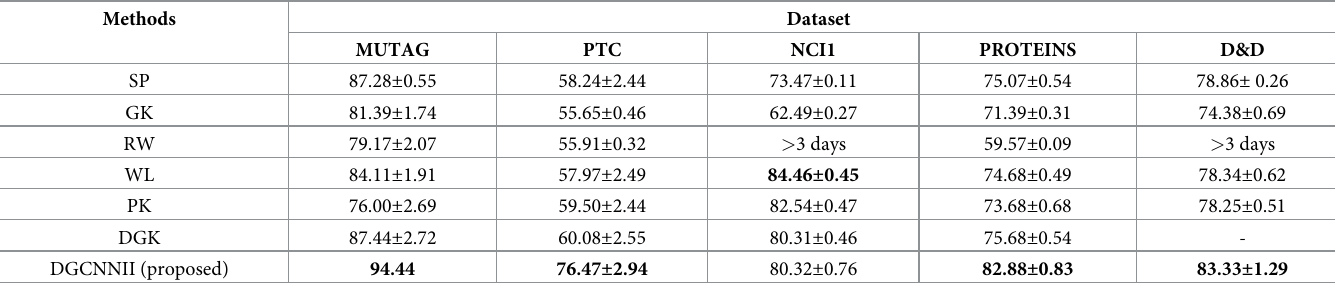
Table 4. Comparison of graph classification accuracy with graph kernel methods.